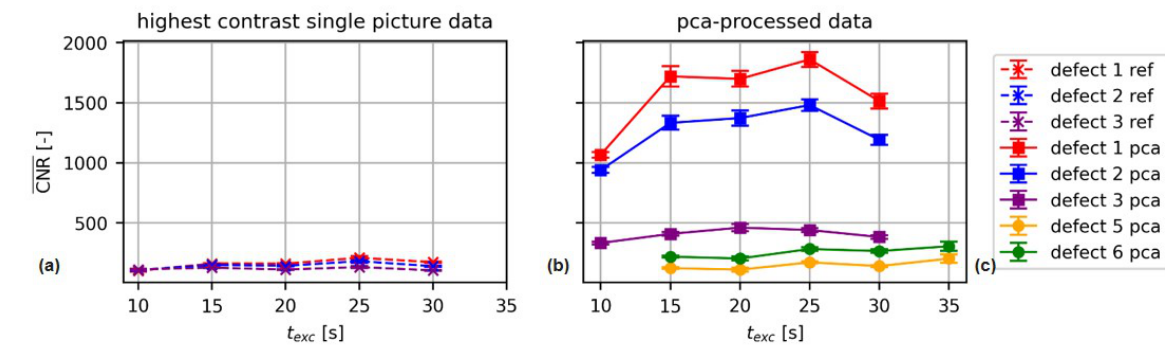
Figure 8. Mean CNR averaged over distance k at different t exc of the defects 1 to 6 with error bars representing the standard deviation of the averaged CNR value, ( a ) reference data with filtering (ref)—note: defect 5 and 6 could not be detected, ( b ) PCA-based data with filtering (PCA), ( c )